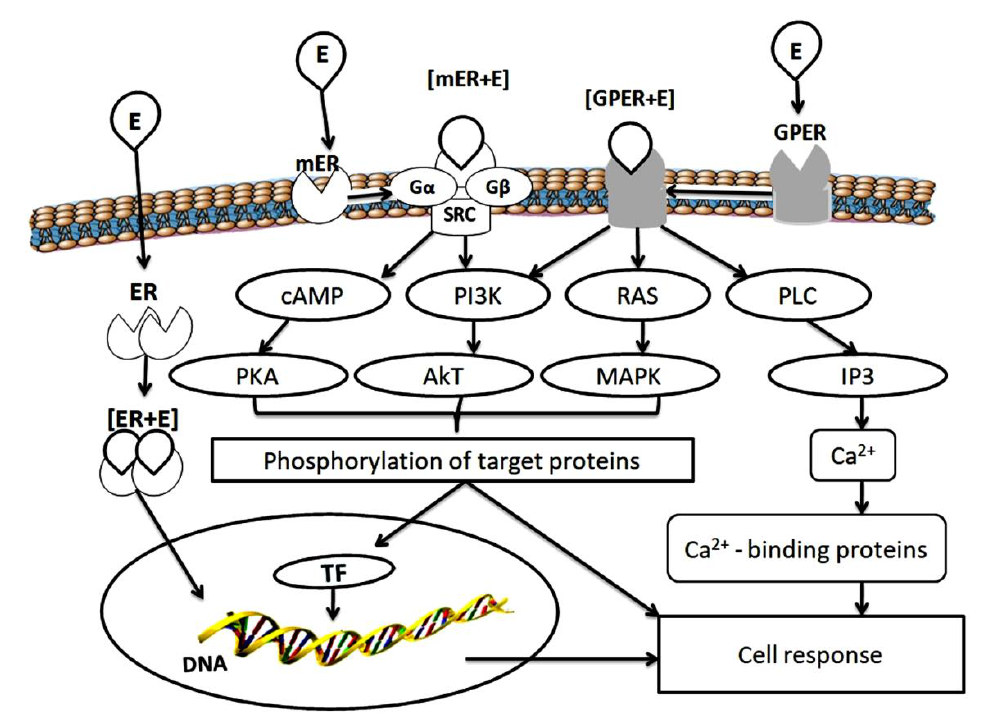
Figure 1. Scheme of estrogen receptor functioning. E—estrogen; ER—estrogen receptor; G α , G β —G proteins; SRC—non-receptor tyrosine kinase; GPER—G protein-estrogen receptor; cAMP—cyclic adenosine monophosphate; PI3K—phosphoinositide 3-kinase; RAS—retrovirus-associated DNA sequence protein; PLC—phospholipase C; PKA—protein kinase A; Akt—protein kinase B; MAPK—mitogen-activated protein kinase; IP3—inositol triphosphate; TF—transcription factors.